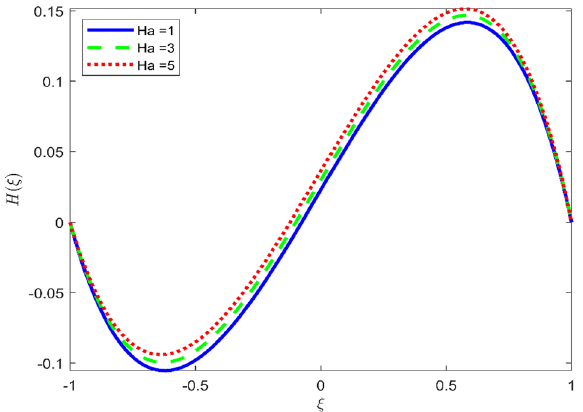
0.2, m 1, φ 1 0.02 , φ 2 φ 3 = = = = =